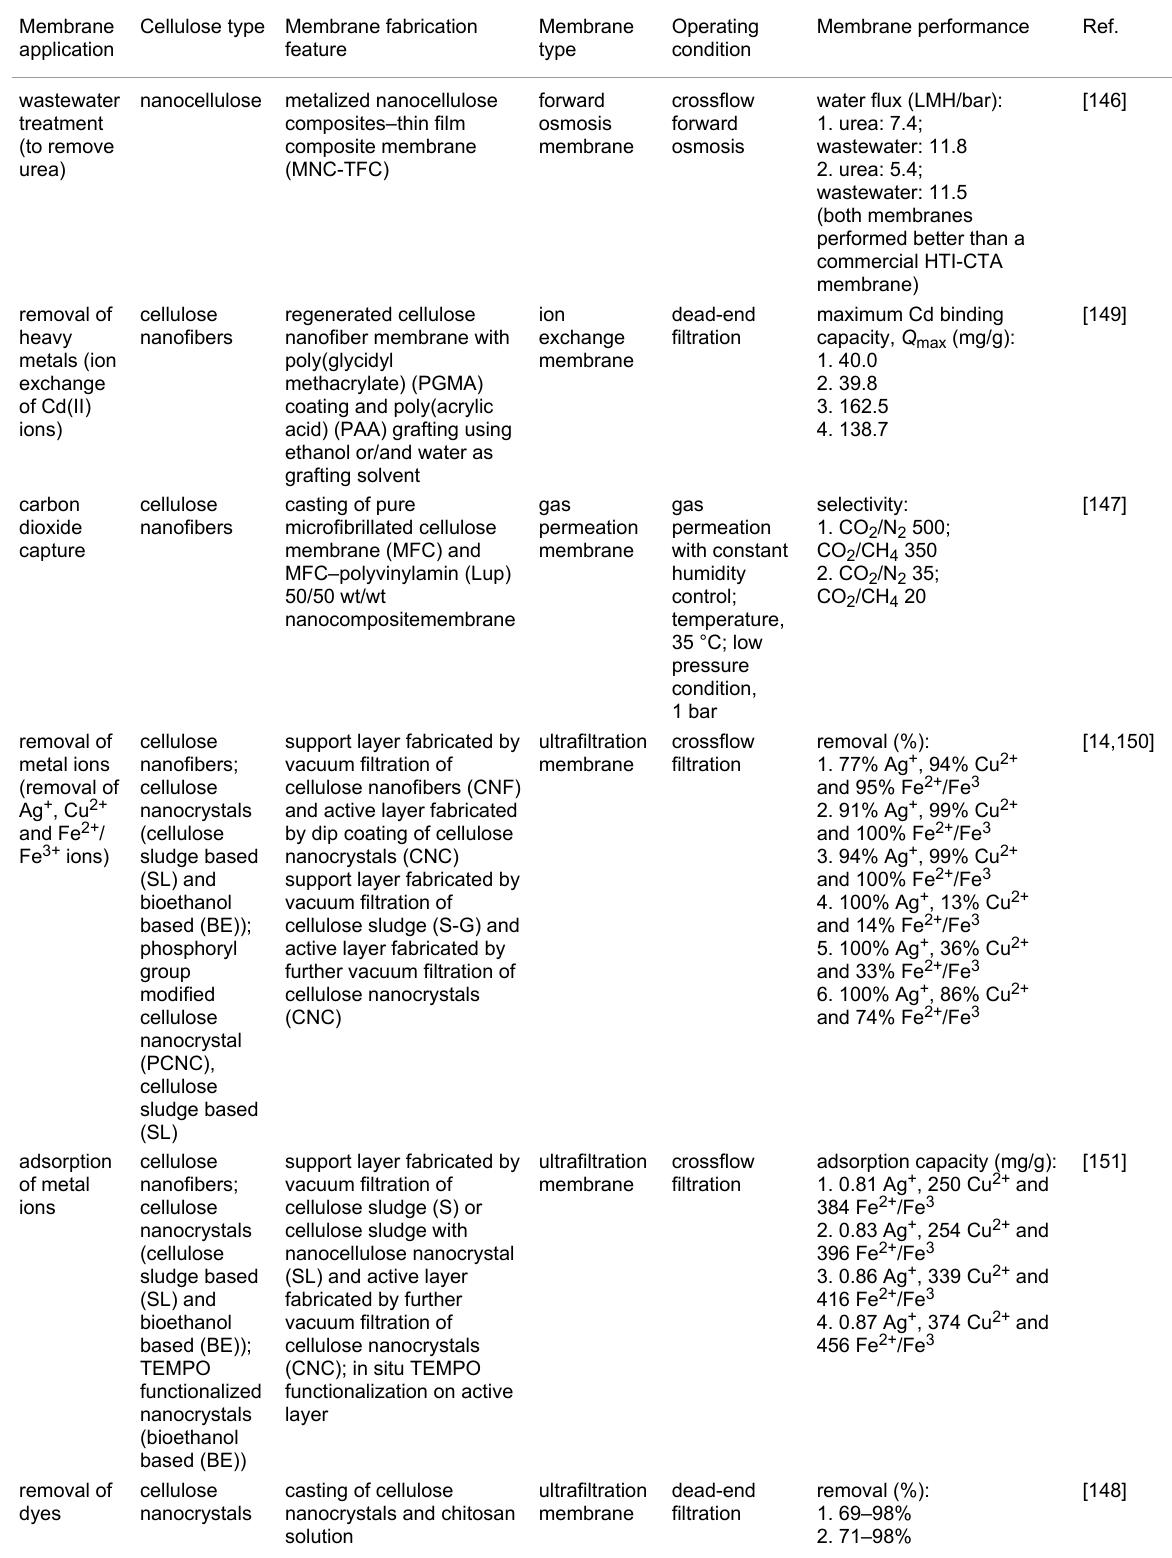
Table 4: Application of nanocellulose material in membrane technology for environmental remediation. Membrane